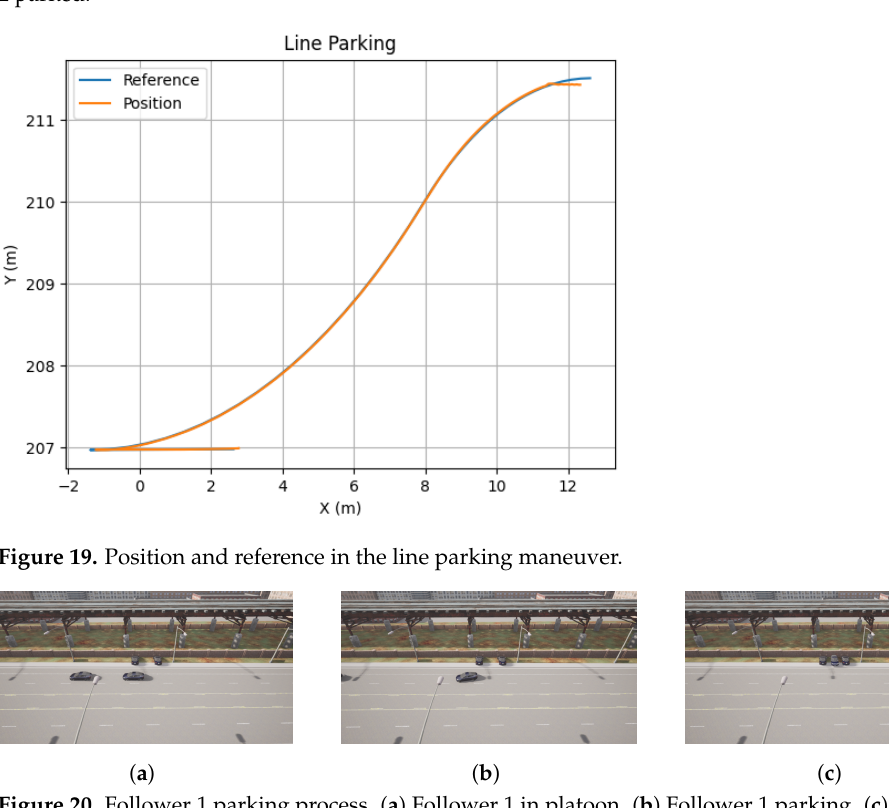
Figure 20. Follower 1 parking process. ( a ) Follower 1 in platoon. ( b ) Follower 1 parking. ( c ) Follower 1